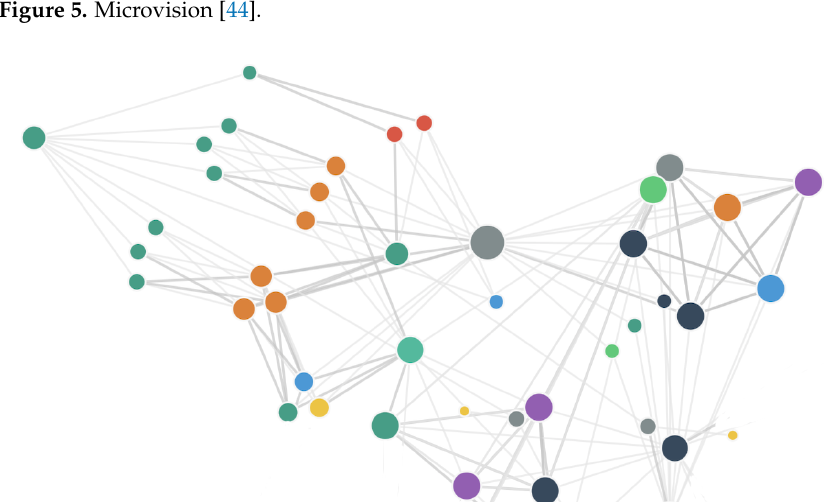
Figure 5. Microvision [44].